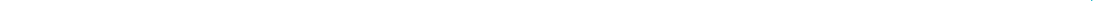
Figure 2: Boxplot for HADS–Depression score, quality of life EQ-5D-3L index score (value set time-trade-off France) and self-perceived quali- ty of life measured by visual analogue scale EQ-VAS for DDRT and LDRT. The solid line represents the median, the hinges of the box the in- ter-quartile range.HADS-Depression 0: no problems. EQ-5D and EQ VAS score 100: best possible state of health. DDRT = deceased donor renal transplant; HADS = hospital anxiety and depression scale; LDRT = living donor renal